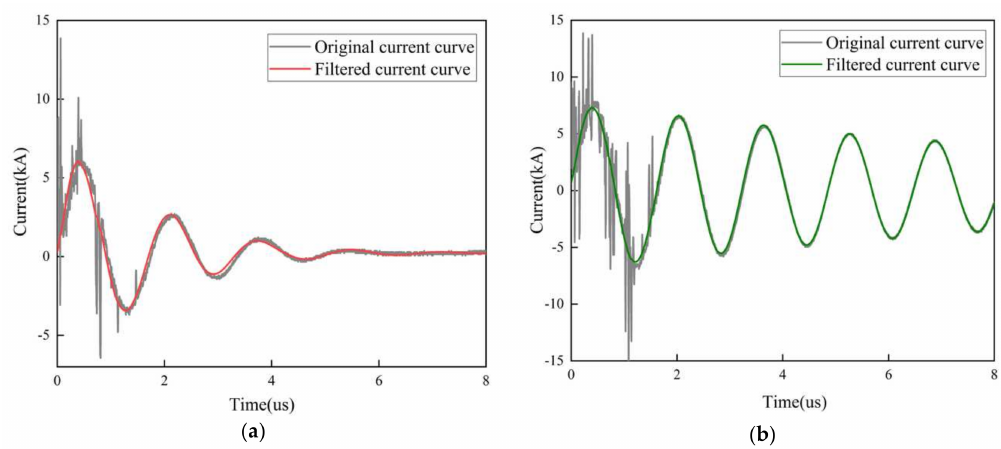
Figure 3. Schematic diagram of EPB test system.